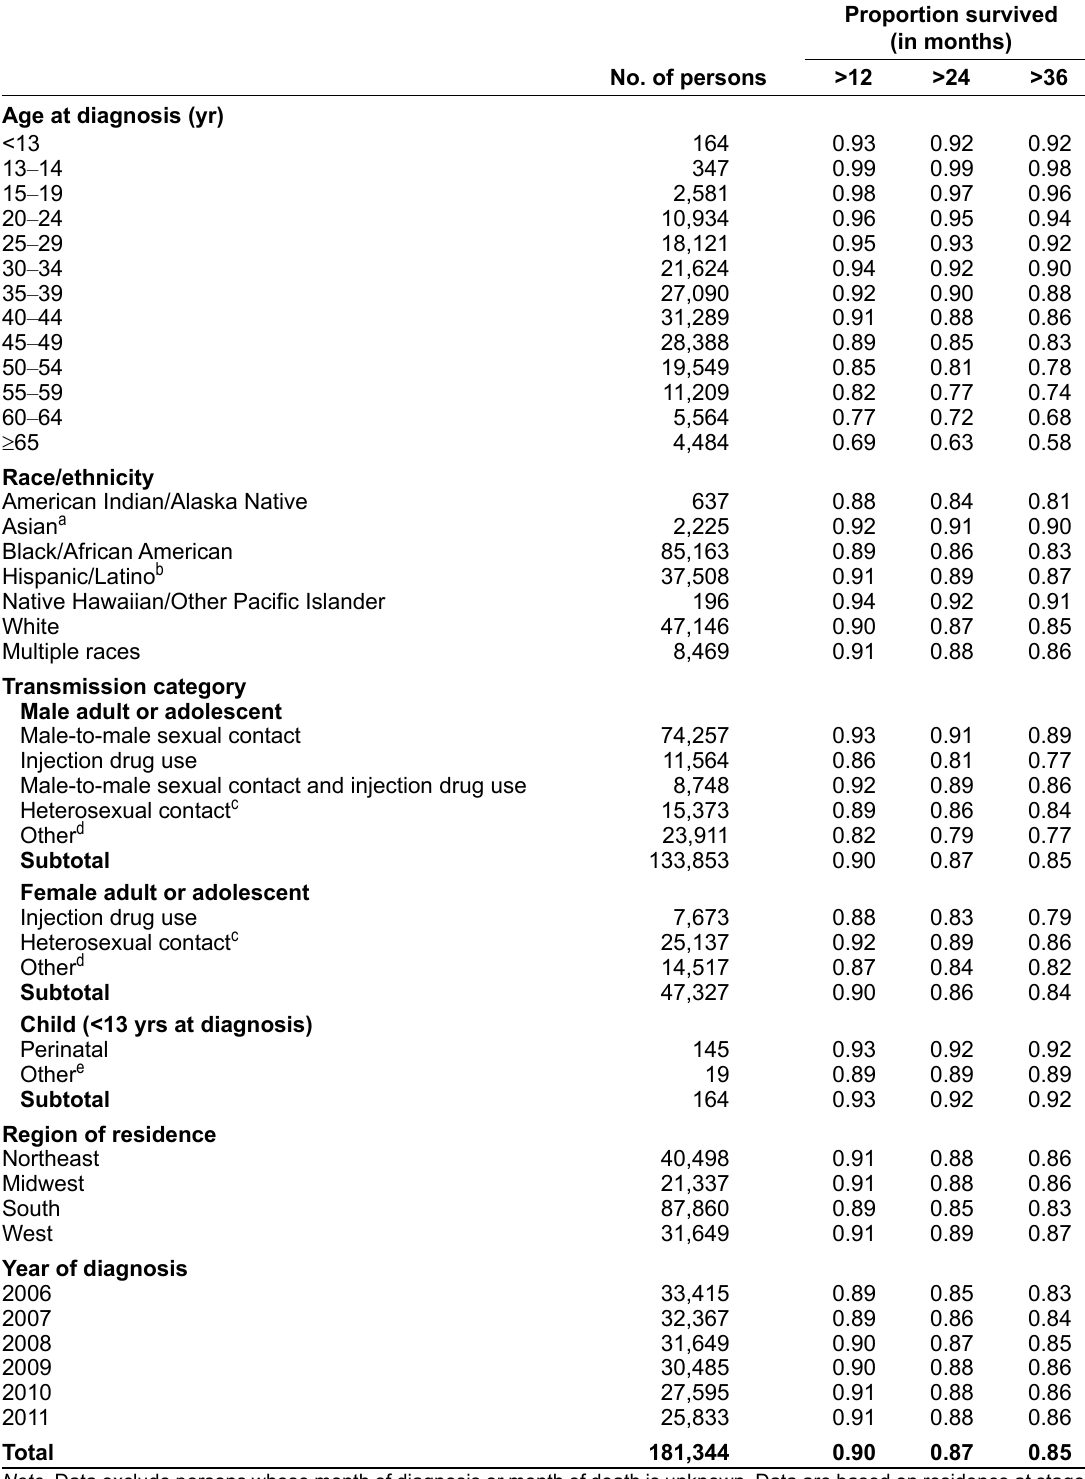
Table 17a. Survival for more than 12, 24, and 36 months after a stage 3 (AIDS) classification during 2006–2011, by selected characteristics—United